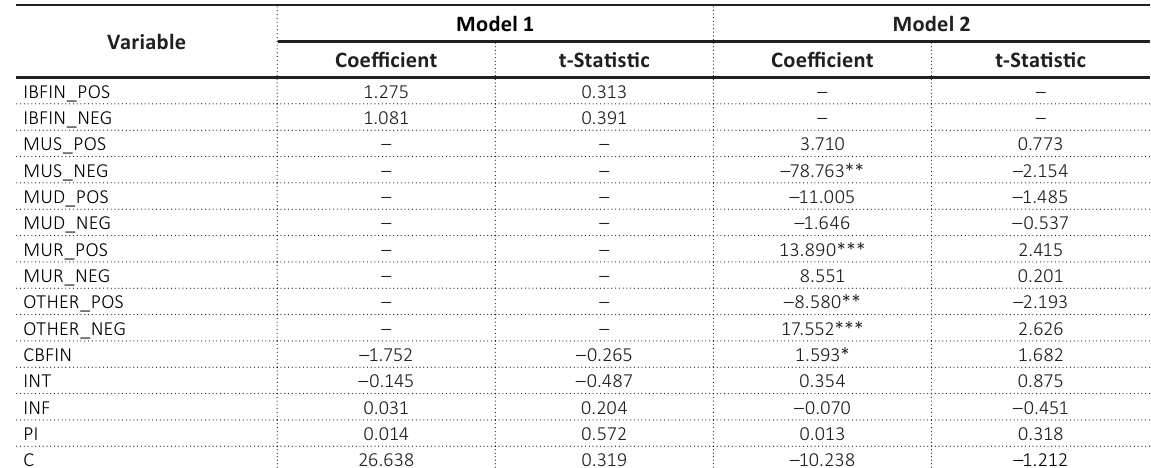
Table 5. Long-run relationships